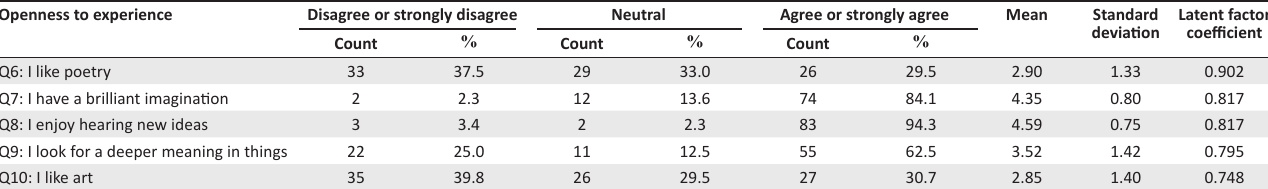
TABLE 2: Descriptive statistics for the construct of openness to experience. Openness to experience